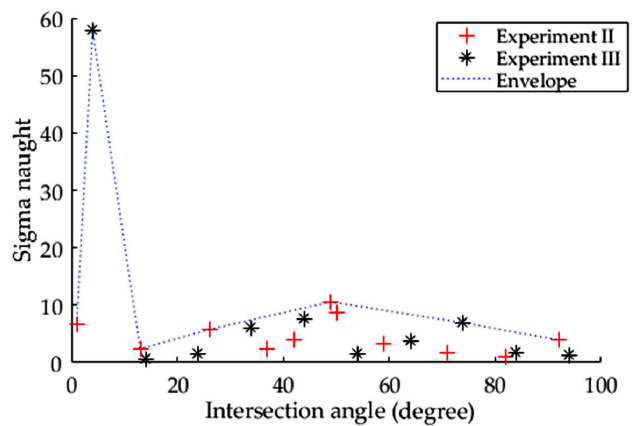
Figure 7. The σ 0 of larger trucks oscillates with increasing intersection angle, as determined in Experiments II and III.